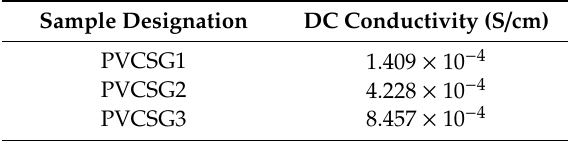
Table 2. DC conductivity values for PVA:CS: LiClO 4 : glycerol